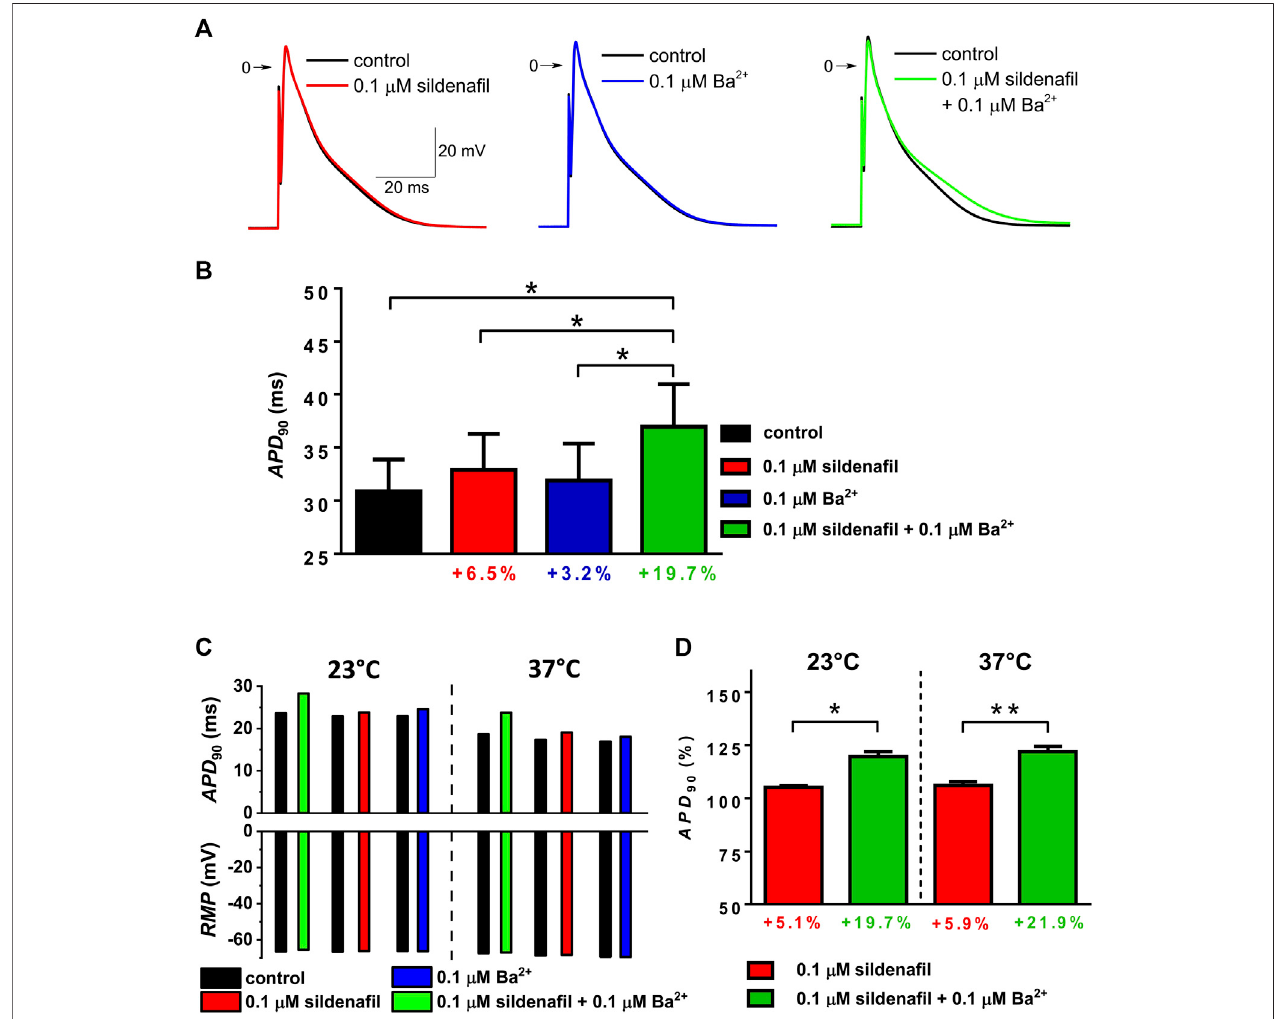
FIGURE5| Changesofactionpotentialduration(APD)undertheeffectof0.1 µMsildena fi laloneandincombinationwithBa 2+ (0.1 µM);APDwasevaluatedat90% repolarization ( APD 90 ). (A) Representative AP waveforms in control and under the effect of the drugs alone and in combination at 23 ° C. (B) Average APD 90 changes at 23 ° C( n =7/3). (C) Valuesof APD 90 andrestingmembranepotential( RMP )inarepresentativecellmeasured bothat23and37 ° C. (D) Comparisonoftheaveragerelative APD 90 changes under the effect of sildena fi l in the absence and presence of Ba 2+ at 23 and 37 ° C ( n = 4/2); * and ** — statistical signi fi cance at p < 0.05 and 0.01, respectively.